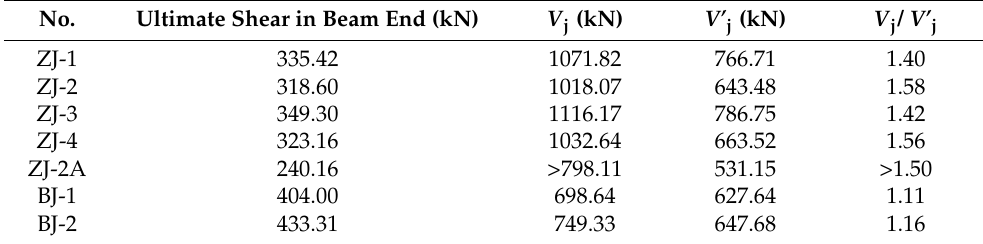
Table 6. Comparison of calculated shear capacity with measured shear